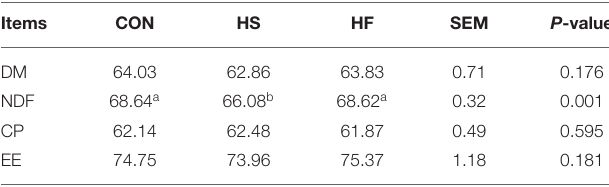
TABLE 4 | Effects of honeycomb flavonoids supplement on cow digestibility under heat stress conditions.